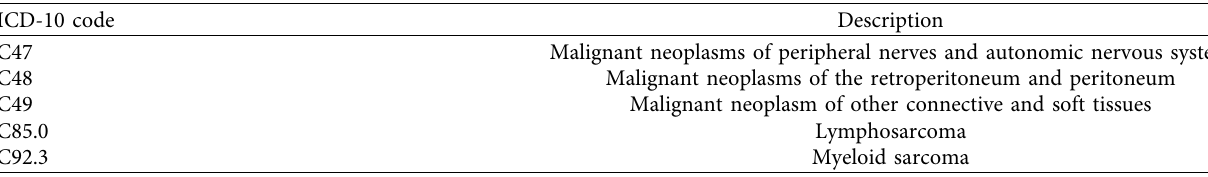
Table 1: ICD-10 codes related to